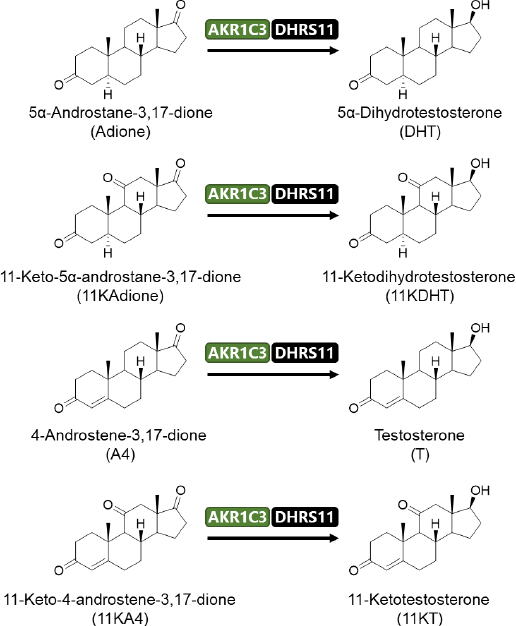
Figure 1. Representative reactions catalyzed by AKR1C3 and DHRS11. The two enzymes catalyze the synthesis of the potent androgens (DHT, 11KDHT, T and 11KT) via their 17βHSD activity.